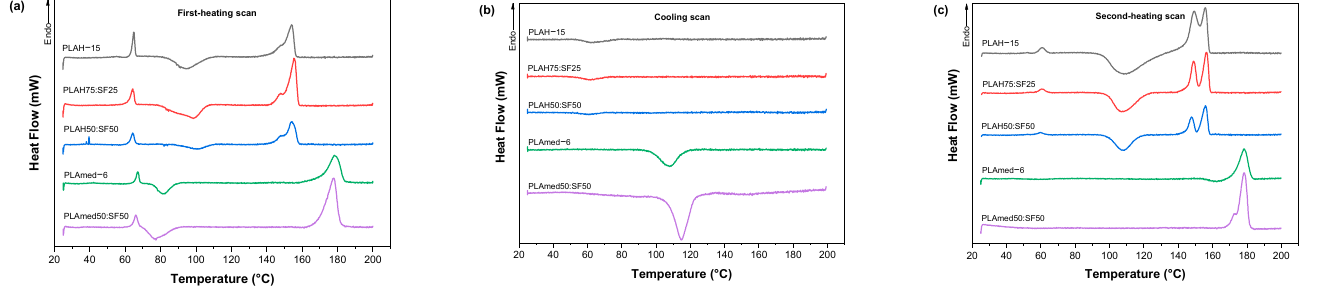
Figure 7. DSC thermograms from ( a ) first-heating scan, ( b ) cooling scan, and ( c ) second-heating scan